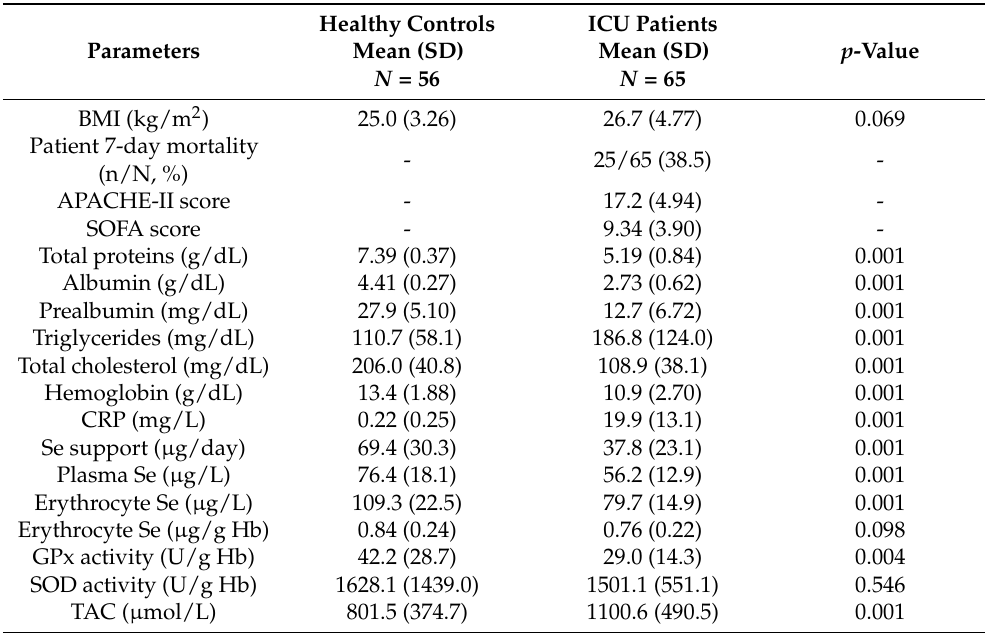
Table 1. Descriptive analysis of the patients at admission to the ICU and the control group, and analysis of the differences between the